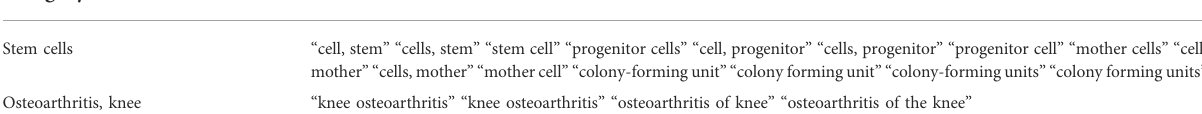
TABLE 1 Search terms divided into two categories, stem cells and osteoarthritis, knee. Category